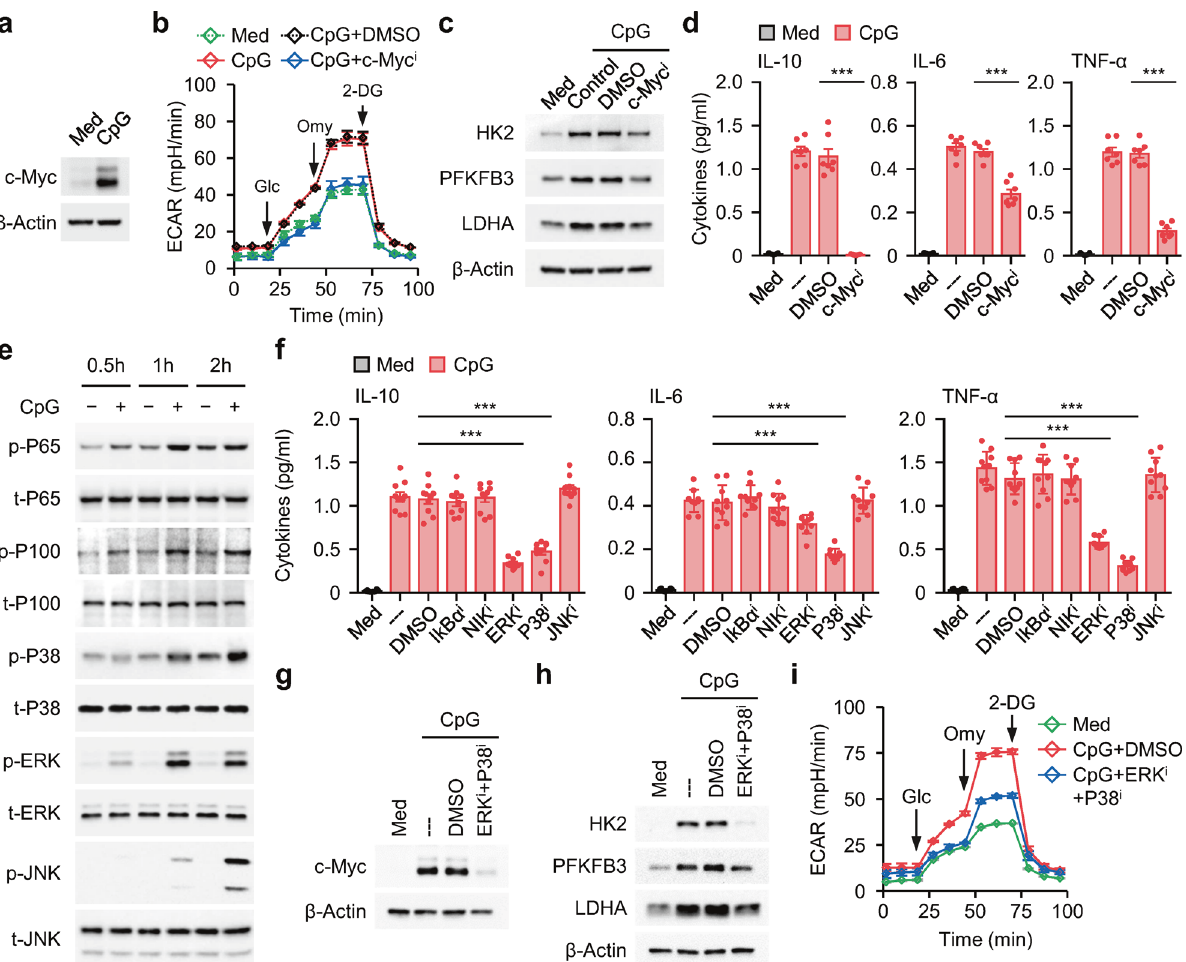
Fig. 5 Signals and transcription factors that triggered B-cell glycolysis and in fl ammatory B reg cell differentiation a Total B cells puri fi ed from healthy donors were cultured in medium or treated with CPG-DNA. c-Myc expression was examined by immunoblotting ( n = 3). b – d Total B cells puri fi ed from healthy donors were cultured in medium or pretreated with DMSO, or inhibitor against c-Myc signals. Thereafter, the cells were cultured in the presence or absence of CPG-DNA. Basal extracellular acidi fi cation ( b ), expression of glycolytic enzymes ( c ), and cytokine secretion ( d ) were detected by seahorse analyzer, immunoblotting, and ELISA, respectively ( n = 3 for b and c ; n = 7 for d ). e Puri fi ed total B cells from healthy donors were cultured in medium or stimulated with CPG-DNA. Activation of MAP kinase and NF- κ B signals were determined by immunoblotting ( n = 3). f – i Total B cells puri fi ed from healthy donors were cultured in medium or pretreated with DMSO, or inhibitor against MAP kinase ( f – i ) or NF- κ B signals ( f ). Thereafter, the cells were cultured in the presence or absence of CPG-DNA. Cytokine production ( f ), expression of c-Myc ( g ) and glycolytic enzymes ( h ), and extracellular acidi fi cation ( i ) were detected by immunoblotting, seahorse analyzer, and ELISA, respectively ( n = 10 for f ; n = 3 for g – i ). Data were acquired from more than four independent experiments and shown as means ± SEM. Signi fi cance was determined with one-way ANOVA test ( d , f ). *** p <